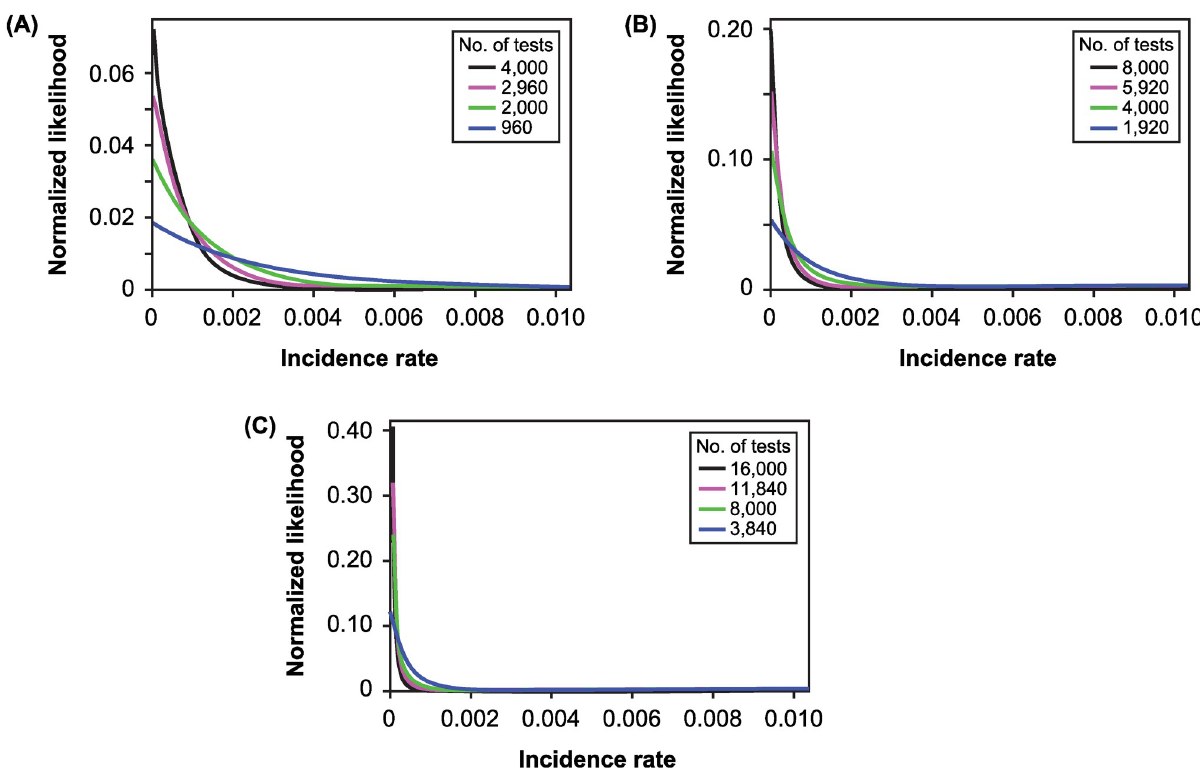
Fig 5. The normalized likelihoods for incidence rate. Shown are normalized likelihoods (i.e., posteriors with a uniform prior) when p FN = 0.25, p FP = 0.05, and positivity is (A) 0.025, (B) 0.0125, or (C) 0.00625. The colored curves correspond to different numbers of tests shown in the legend inset; since positivity is specified, higher numbers of tests are associated with lower levels of